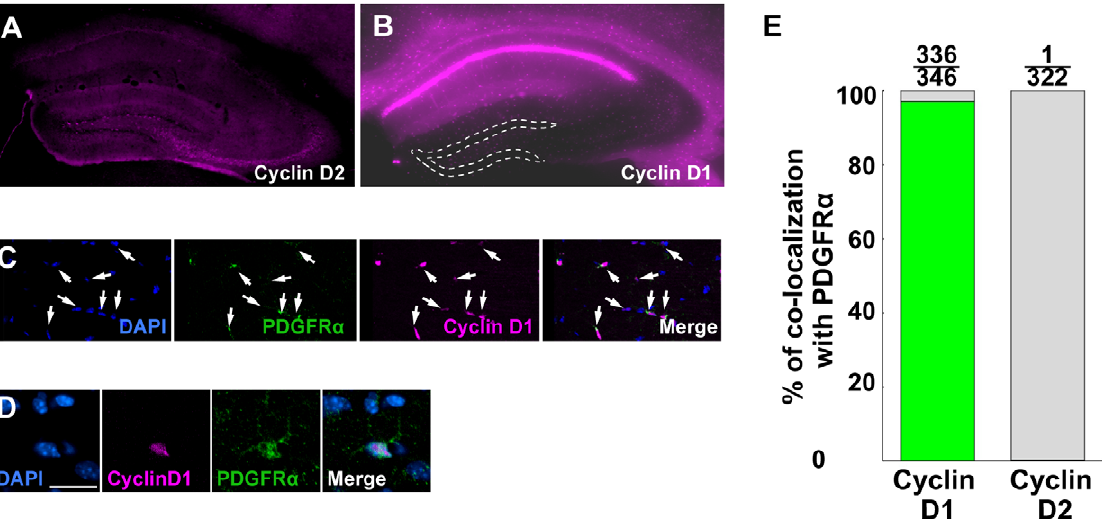
Figure 3. Cyclin D1 is expressed in OPCs in the hippocampus. (A) Immunostaining with anti-cyclin D2 antibody in the hippocamous. Immunoreactive signals were seen along the SGZ of the DG. (B) Immunostaining with anti-cyclin D1 antibody in the hippocampus. White dots show the margin of the DG. The bright band of immunoreactivity seen above the DG is the cluster of pyramidal neurons in CA1 as previously reported [47]. (C and D) Double immunostaining with anti-PDGFR a and anti-cyclin D1 antibodies in the hippocampus. White arrows indicate PDGFR a -positive cells that are positive for cyclin D1. Higher magnitude image of double positive cell (D). Scale bar: 20 m m. (E) The percentage of cells positive for each marker among all PDGFR a -positive cells.